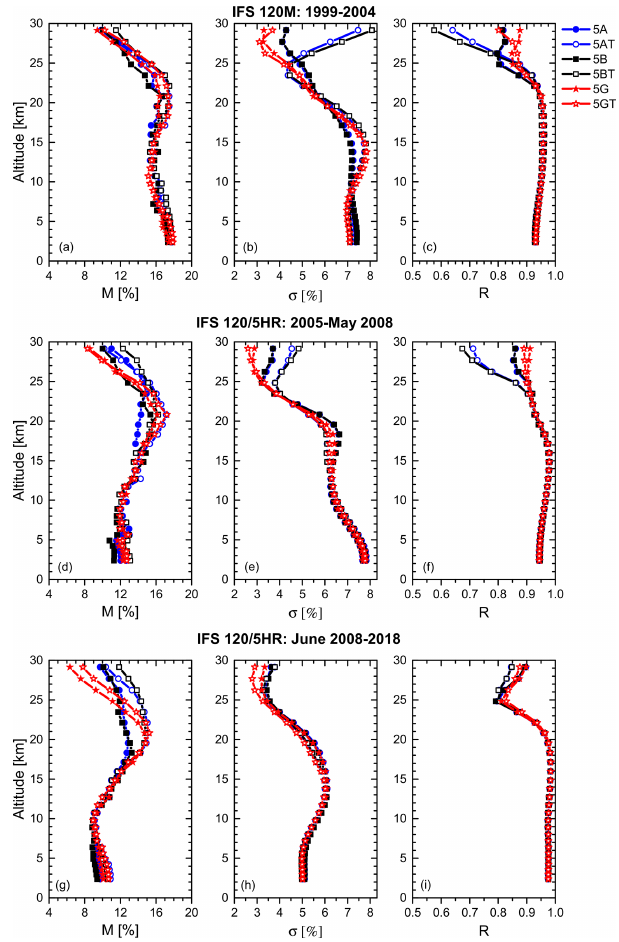
Figure 7. Summary of FTIR-smoothed ECC comparison for the periods 1999–2004, 2005–May 2008, and June 2008–2018. Pan- els (a) , (d) , and (g) display the vertical profiles of the median ( M ) RD (FTIR-ECC, in %) for the three periods, respectively. Panels (b) , (e) , and (h) are the same as (a) , (d) , and (g) but for the stan- dard deviation of RD distributions ( σ , in %). Panels (c) , (f) , and (i) are the same as (a) , (d) , and (g) but for the Pearson correlation coefficient. The number of coincident FTIR-ECC measurements is 56, 49, and 167 for the periods 1999–2004, 2005–May 2008, and June 2008–2018, respectively.